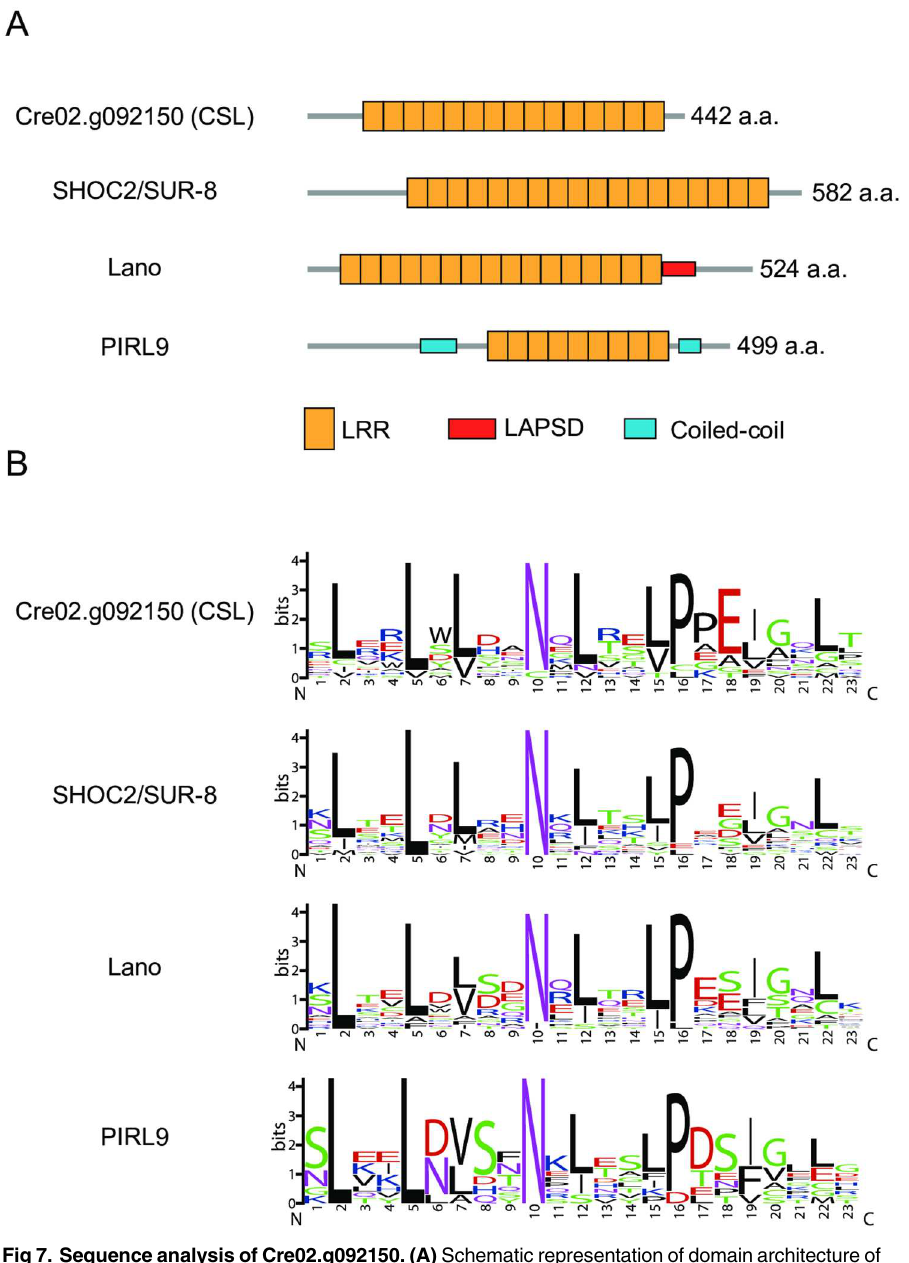
Consensus LRR sequencesvisualizedby the